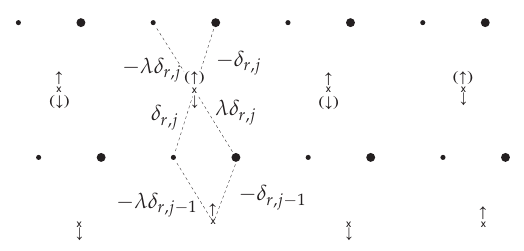
) interaction of the Riera-Poilblanc model [25] in systems like (TMTSF) 2 X , ×